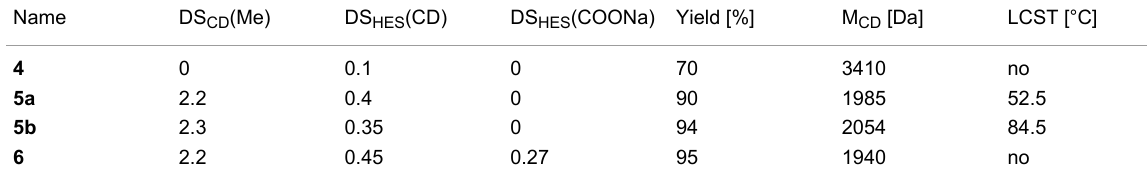
Table 1: Compositions, yields, and LCST of methylated CD-HES conjugates synthesized by [2 + 3]